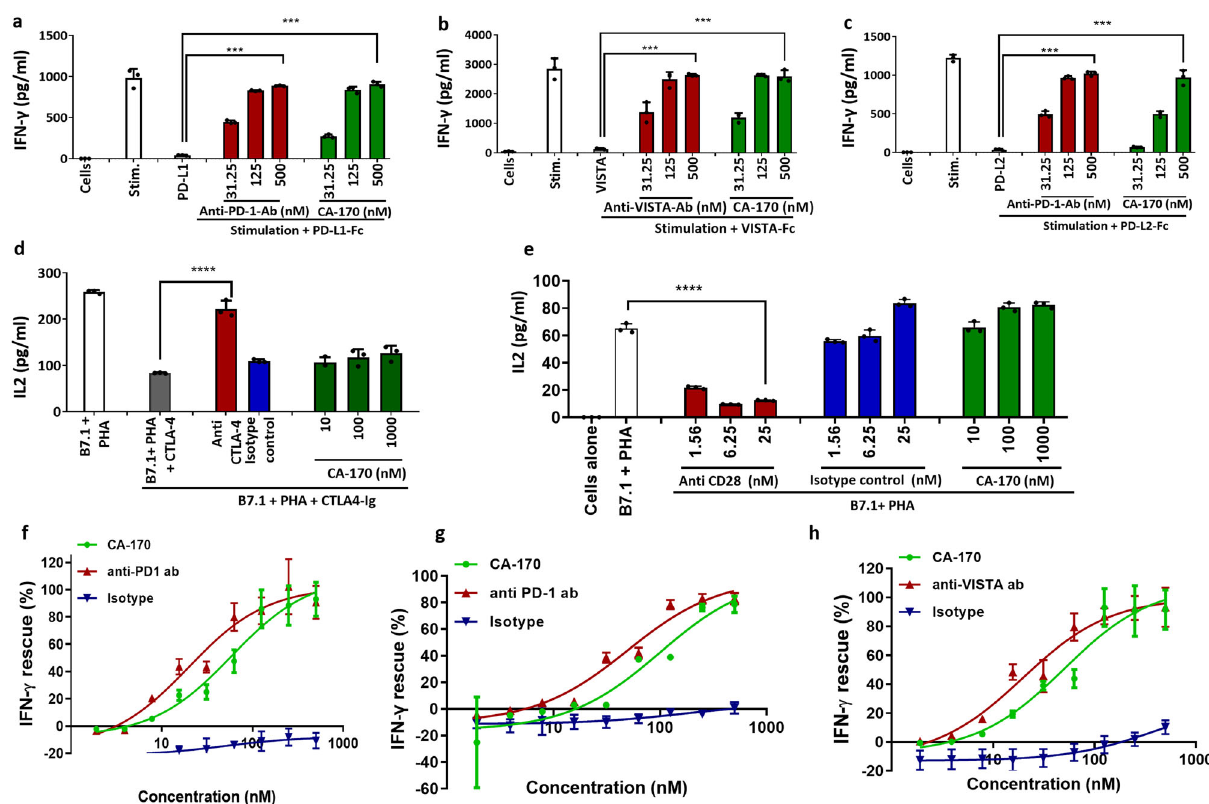
(Fig. 1f – h). The average EC 50 data from three independent experiments for rescue of proliferation and IFN γ release are tabulated in Supplementary Table 2. When similar assays were done using mouse splenocyte and non-human primate PBMCs in the presence of PD-L1, CA-170 also showed potent activity in rescuing the splenocytes/PBMC proliferation and IFN- γ release inhibited by PD-L1 (Supplementary Table 3), indicating its activity in these preclinical